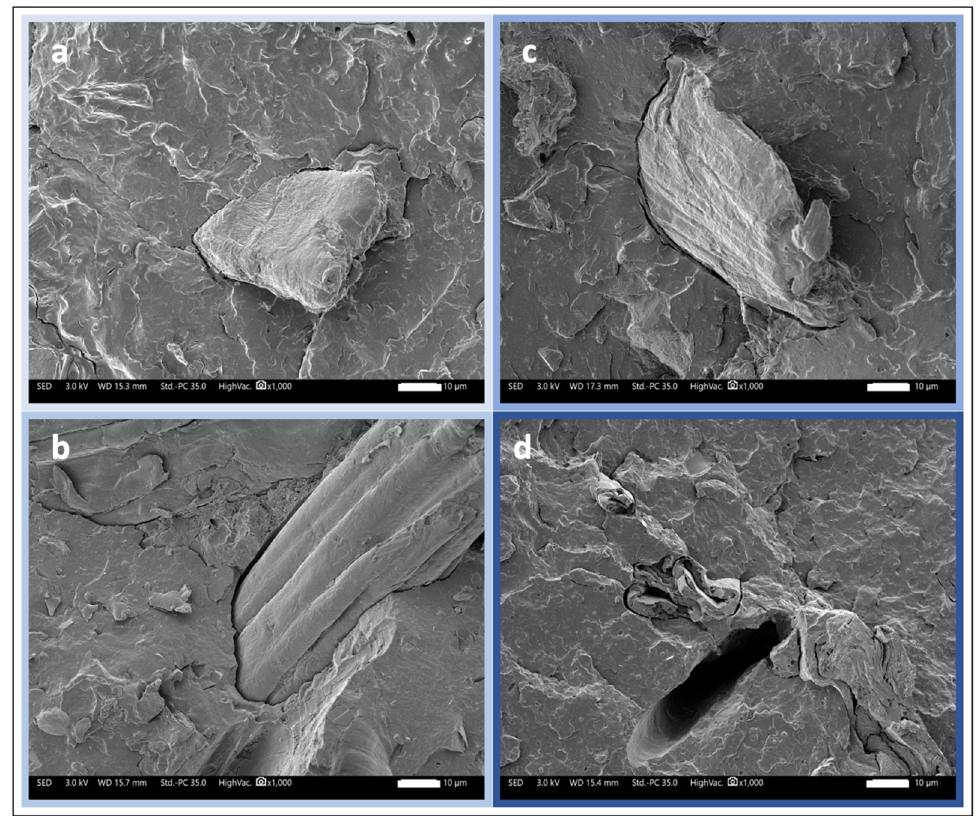
Figure 8. SEM images of fiber ‐ matrix interface for PBS ( a ), PHA ( b ), PLA ( c ), and PP ( d ) tomato reinforced composite materials.